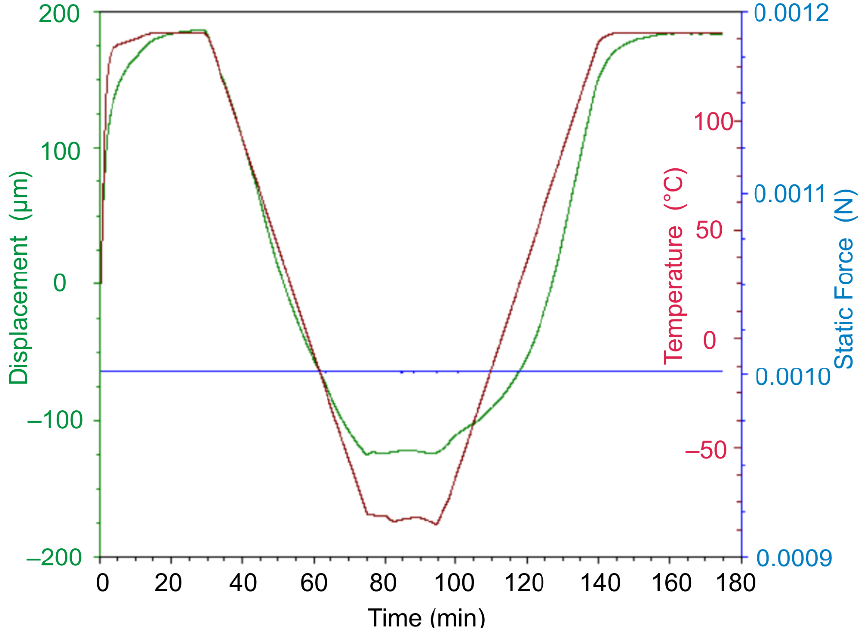
Figure 2. Characteristic time dependencies of the parameters recorded during the experiment, for the sample made of DeSolite DS-2015 polymer, cooling and subsequent heating rate 2 °C/min. Specimen size is 13.461 mm × 6.2 mm × 0.045 mm.